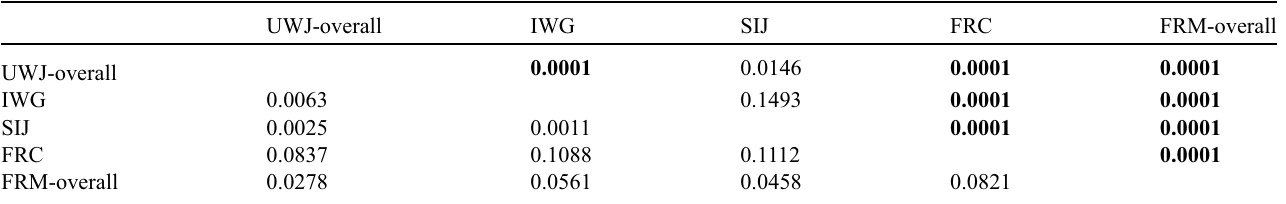
Table 3. Pairwise genetic differentiation ( F st) in three wild caught populations (specimens of UWJ caught by different methods were included in “ UWJ-overall ” ), arti fi cial seedlings for stock enhancement and farmed individuals and its P -values.